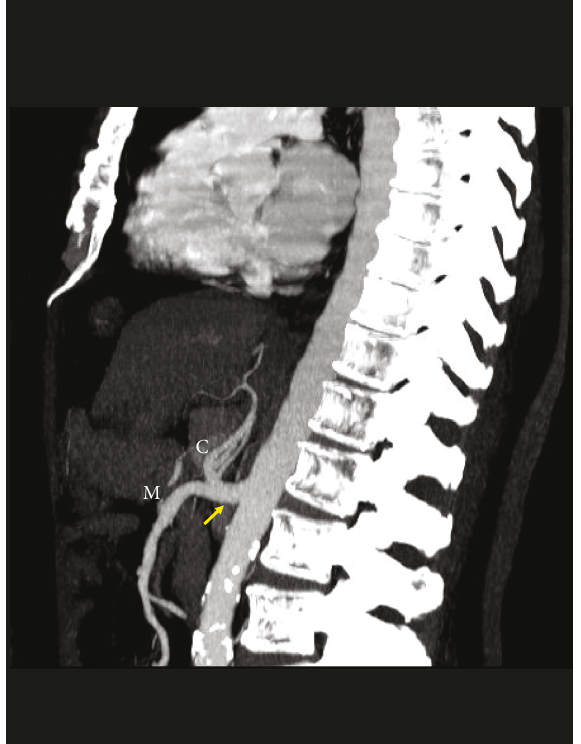
Figure 4: Three-dimensional volume rendering CTimage showing a complete CMT (arrow). The celiac branches visible include the splenic (1), left gastric (2), common hepatic (3), and gastroduo- denal arteries (4). The mesenteric branches visible include the inferior pancreaticoduodenal (4) and superior mesenteric ramifi- cations